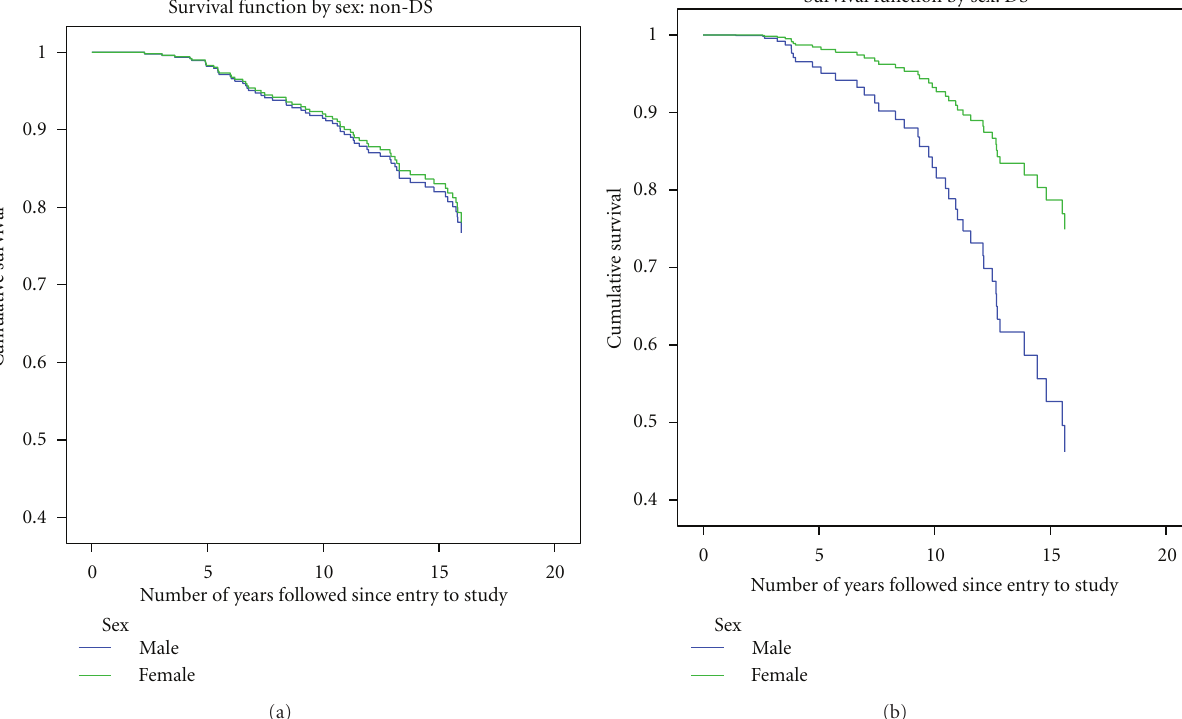
Figure 4: Adjusted survival curves of 360 participants with ID (1995–2011): impact of sex: non-DS compared to